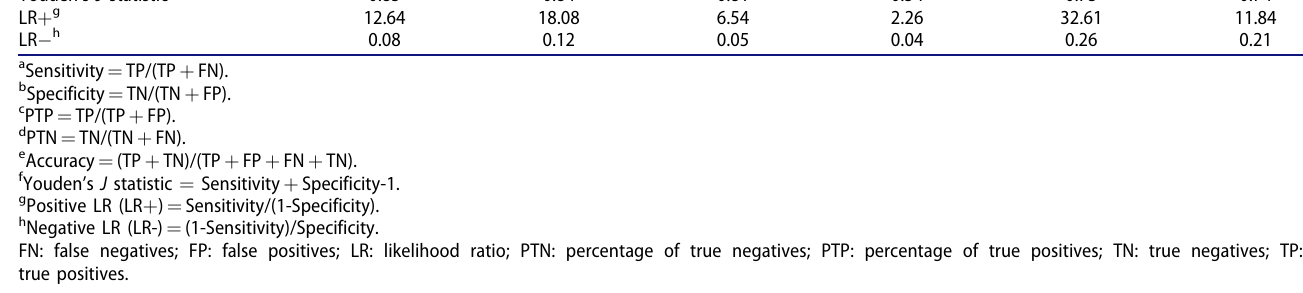
Table 2. Area under the curve (AUC) values for conventional and novel markers. Marker AUC